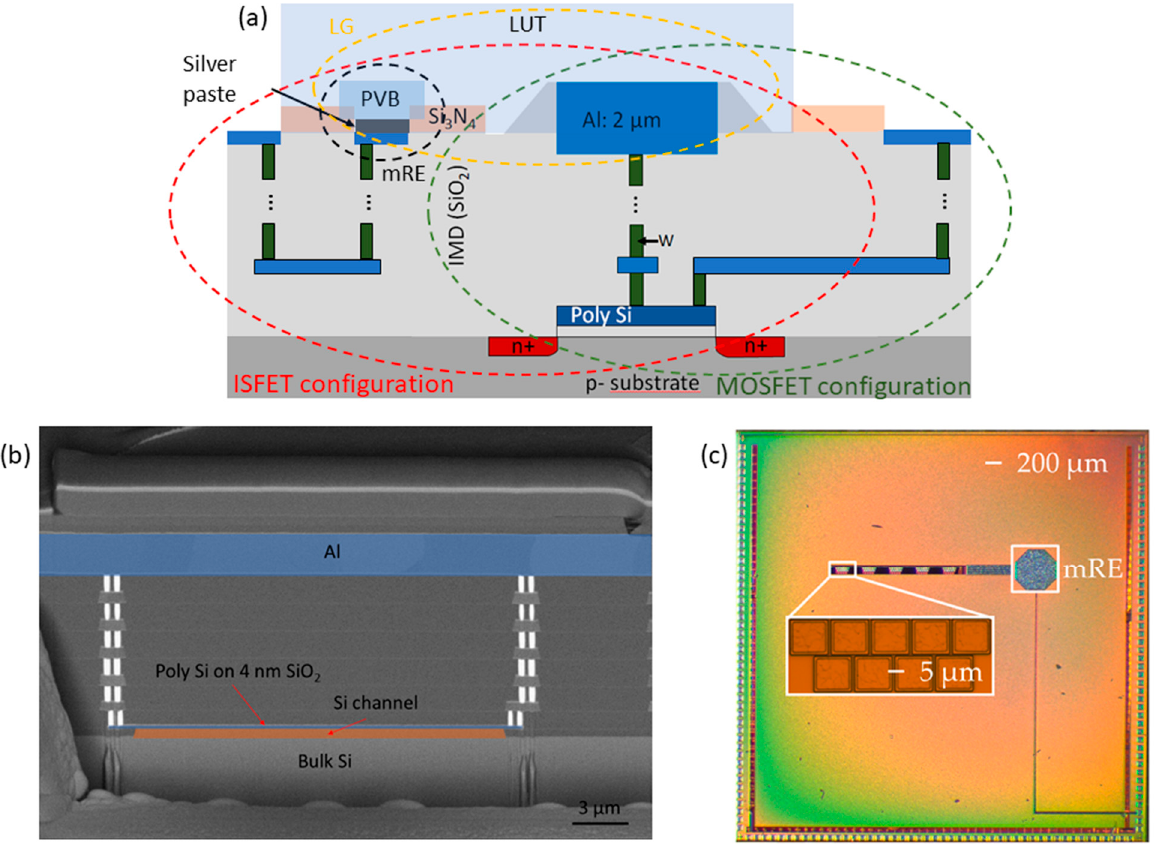
Figure 1. Modified-back-end of line (BEOL) by post-processing a foundry-made complementary metal-oxide semiconductor (CMOS) chip to allow for a liquid under test (LUT) experiment aiming at pH sensing. ( a ) Schematic cross-section of the FET/ISFET, showing how the same device can be characterized in two configurations. ( b ) TEM image of a section of the foundry-made FET, before BEOL modification. This version of the device has a wider Al contact than the one used in our study, but was otherwise identical. ( c ) Optical image of the top view of the sensing chip, showing the base contact for the miniaturized reference electrode (mRE) and the top gates of the five sets of nine ISFETs.